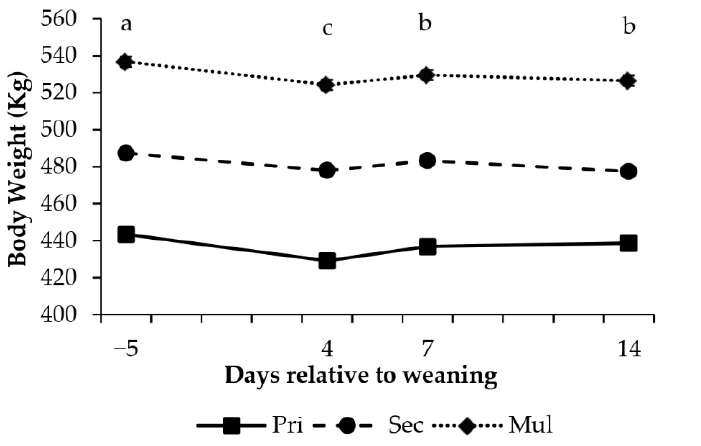
Figure 1. The body weight of Nellore cows with different parity under grazing according to the days relative to weaning. Days with different superscripts differ from each other for all parity orders ( p < 0.05).